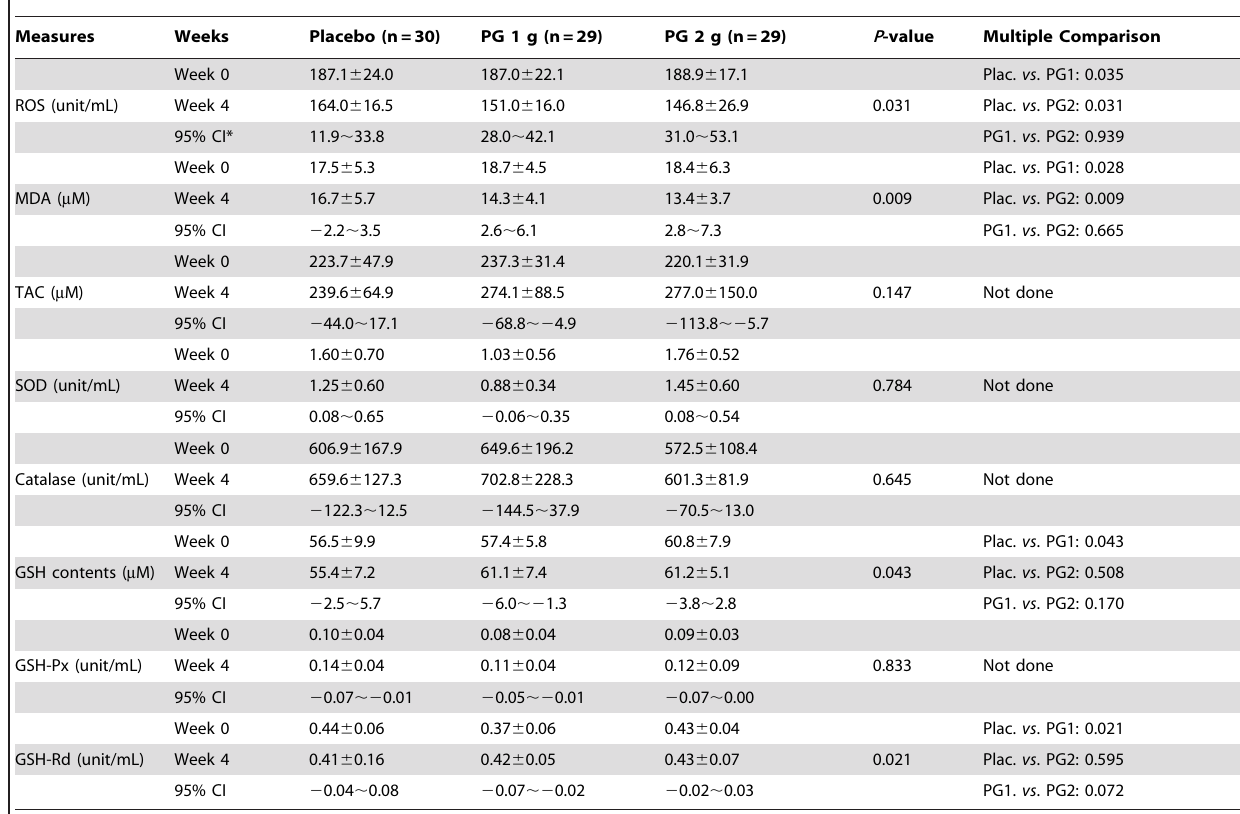
Table 4. Serum levels of oxidative stress and antioxidant system